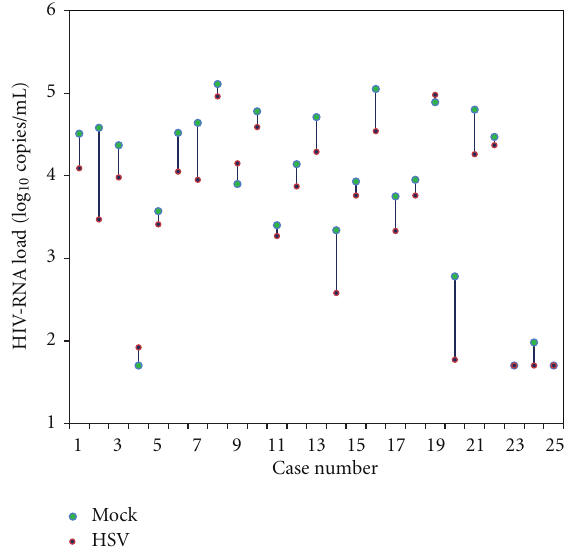
Figure 1: HIV-RNA load obtained from mock and HSV-1 infected PBMCs of 25 HIV-infected individuals.